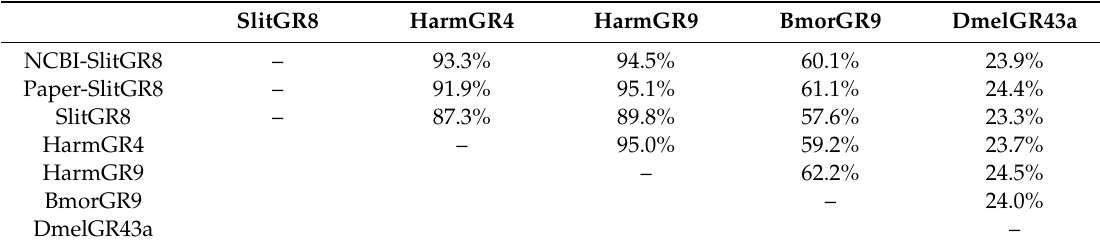
DmelGR43a – Insect species and GenBank IDs of the GR genes are: Spodoptera litura (SlitGR8), this study; Bombyx mori (BmorGR9), XP_012551875.1; Helicoverpa armigera (HarmGR4), AGK90011.1; (HarmGR9), AGA04648.1; Drosophila